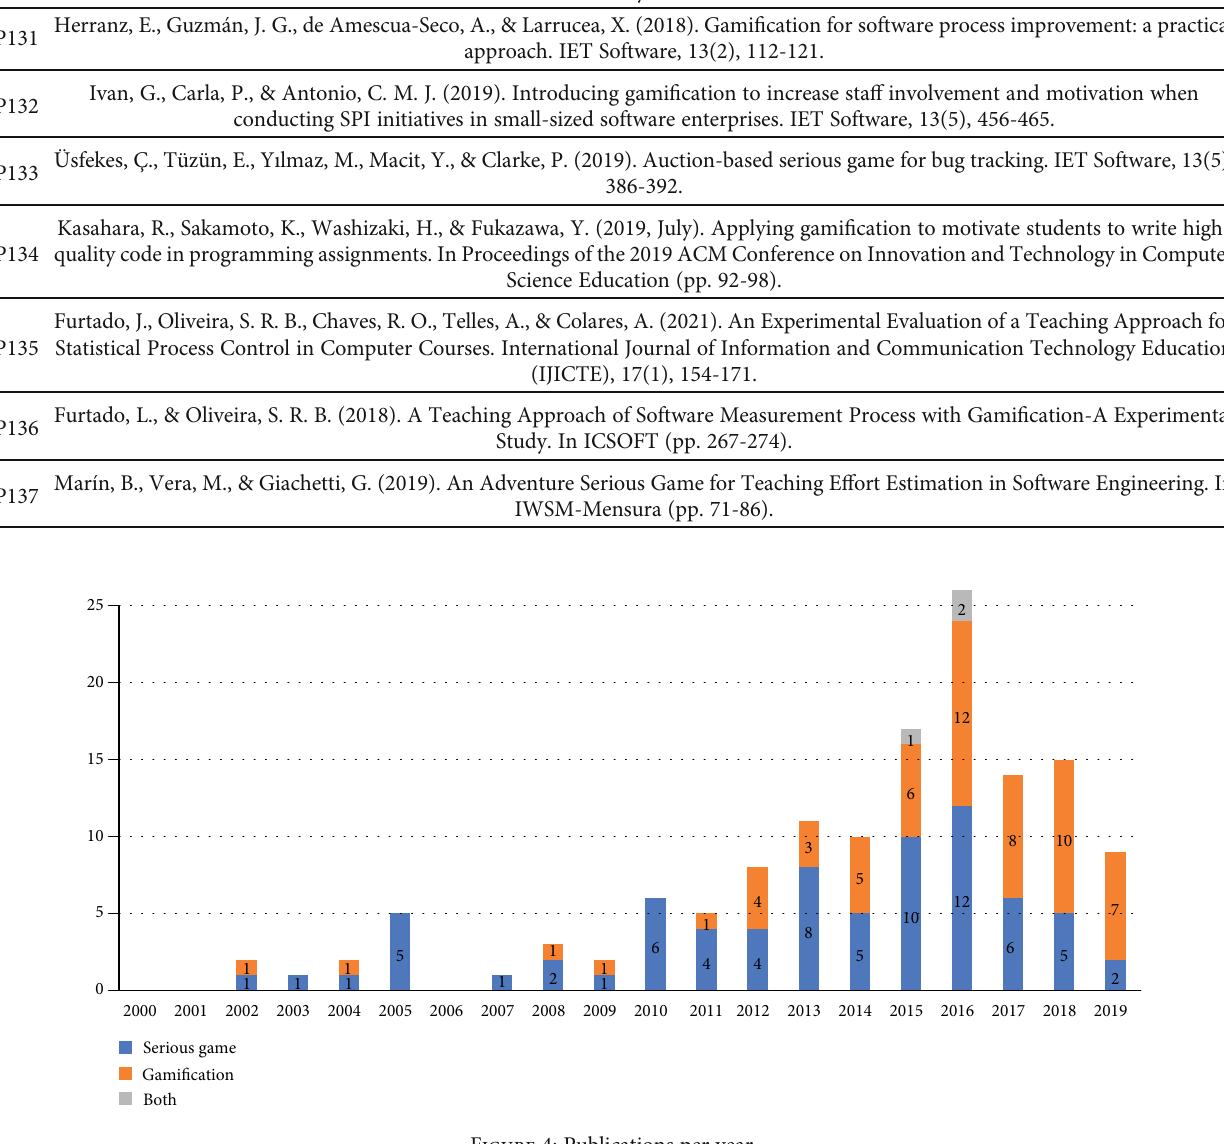
Figure 4: Publications per